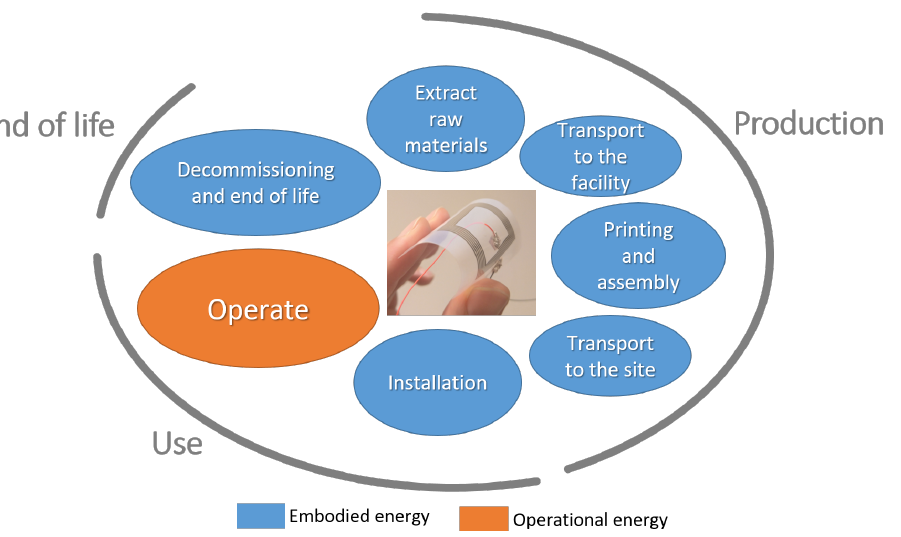
Figure 19. Holistic overview for life-cycle of a printed electronics device. Operational energy is the energy required to use the device while embodied energy refers to the consumed energy by the processes associated with the production and end of